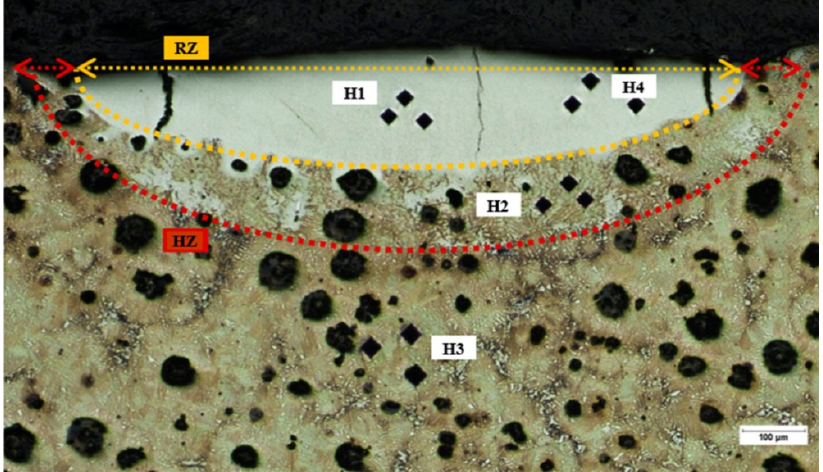
Figure 3. Current zones in the weld seam of the laser surface hardened melting (LSM).